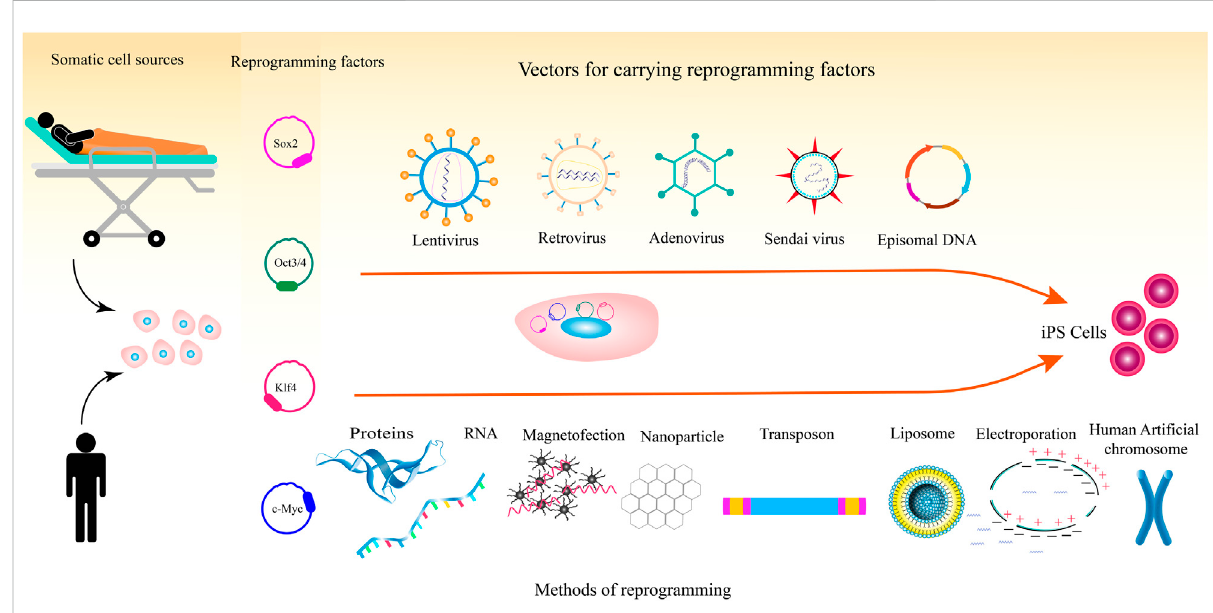
FIGURE 1 Process of reprogramming somatic cells to iPSCs including somatic cell types, reprogramming factors, and methods for the delivery of the reprogramming